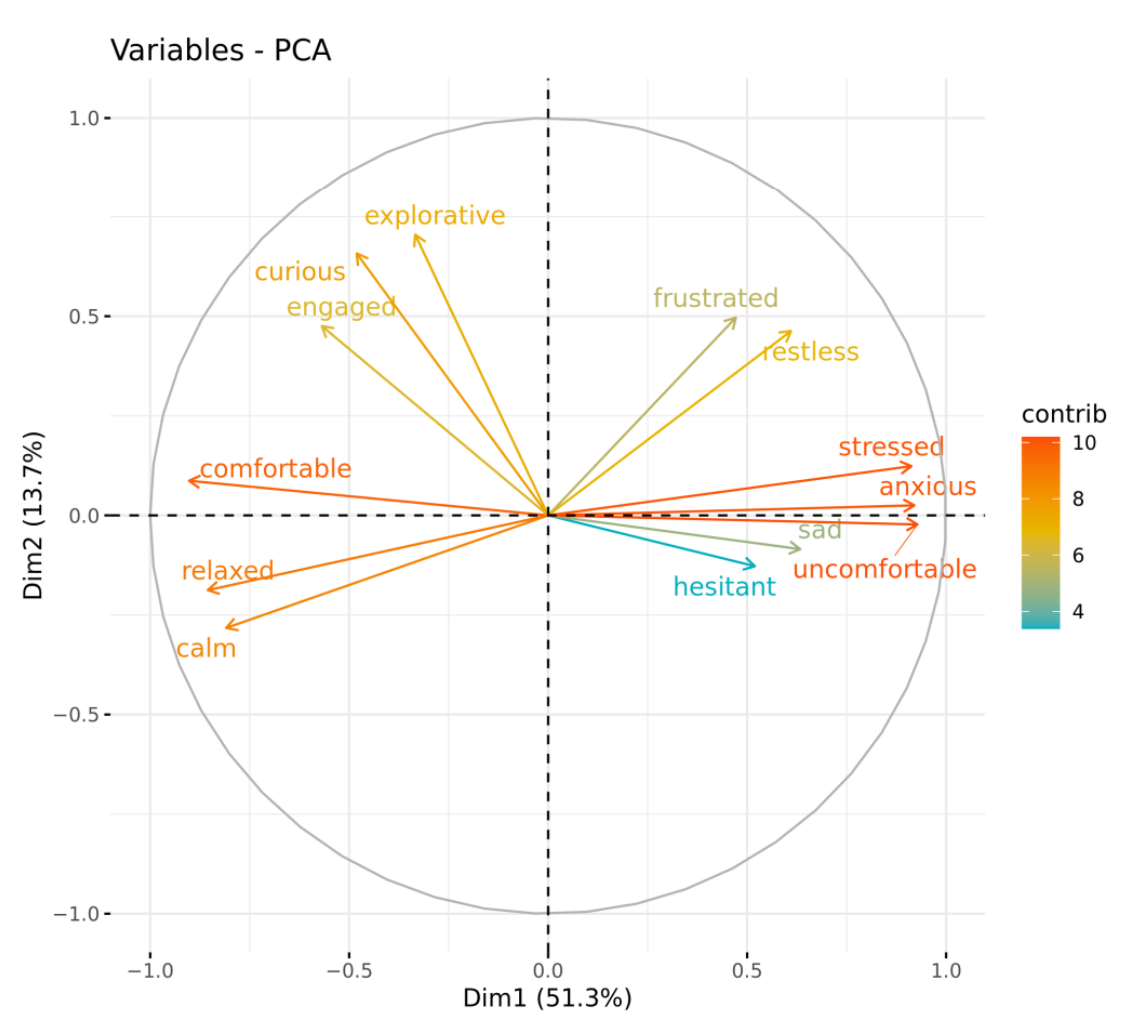
Figure 6. Plot of component loadings generated from a PCA of QBA terms showing the two main components of interest (Dim1: Stressed/Anxious, Dim2: Interactive) with arrow color indicative of the strength of contribution of the term.